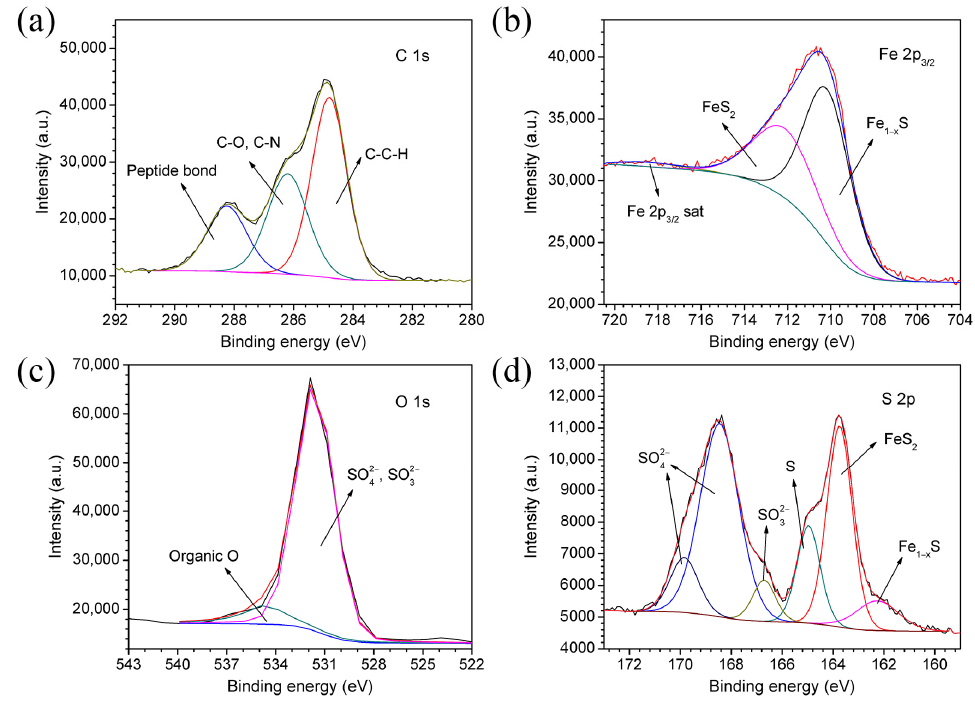
Figure 3. Chemical composition of the corrosion products after 7-day incubation in an SRB-Z-inoculated media. High resolution XPS spectra of ( a ) C 1s, ( b ) Fe 2p, ( c ) O 1s, and ( d ) S 2p.